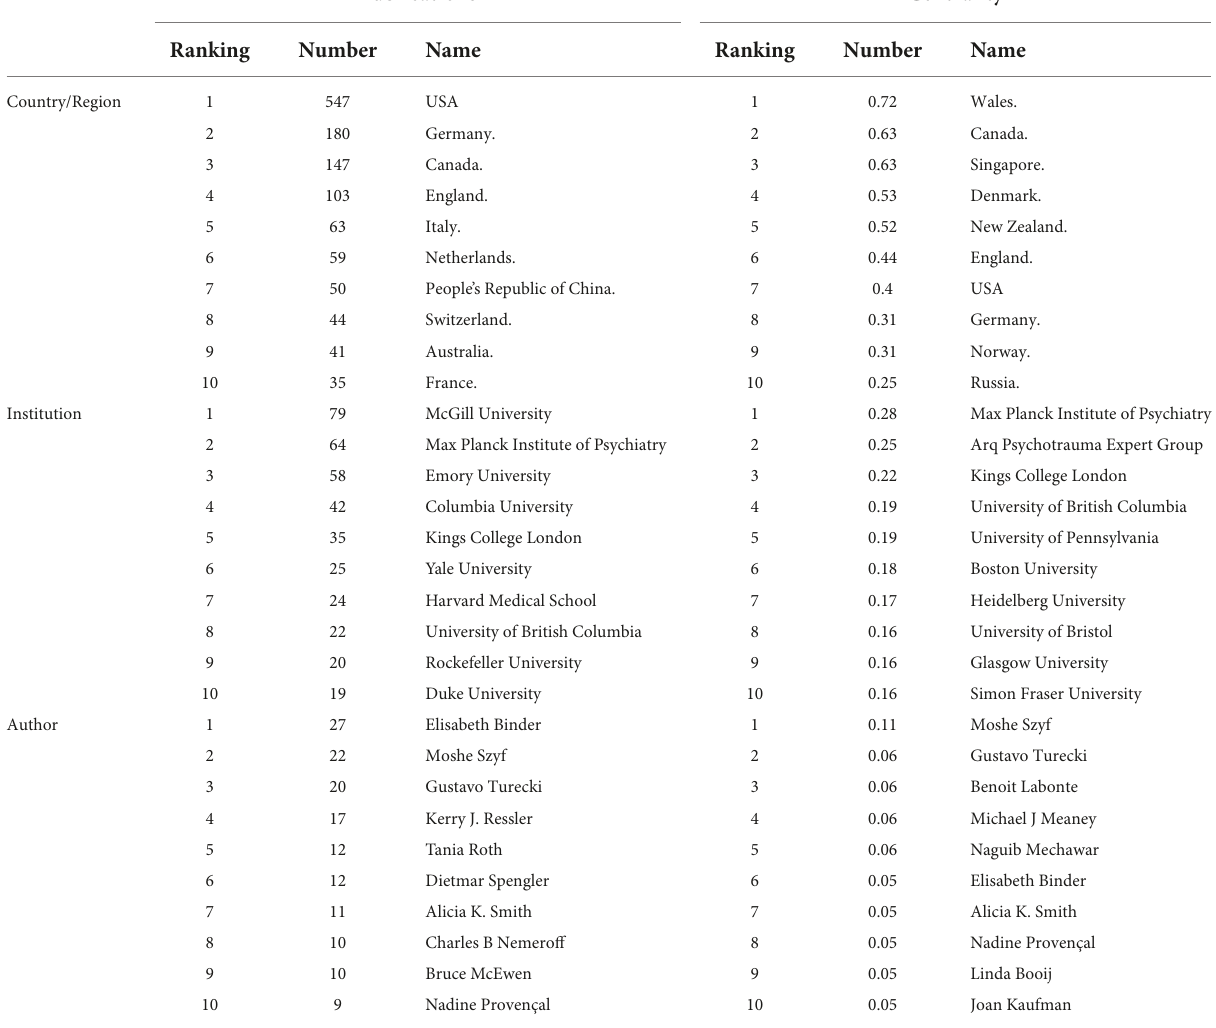
TABLE 1 Top 10 countries/regions, institutions, and authors in terms of publications and centrality.